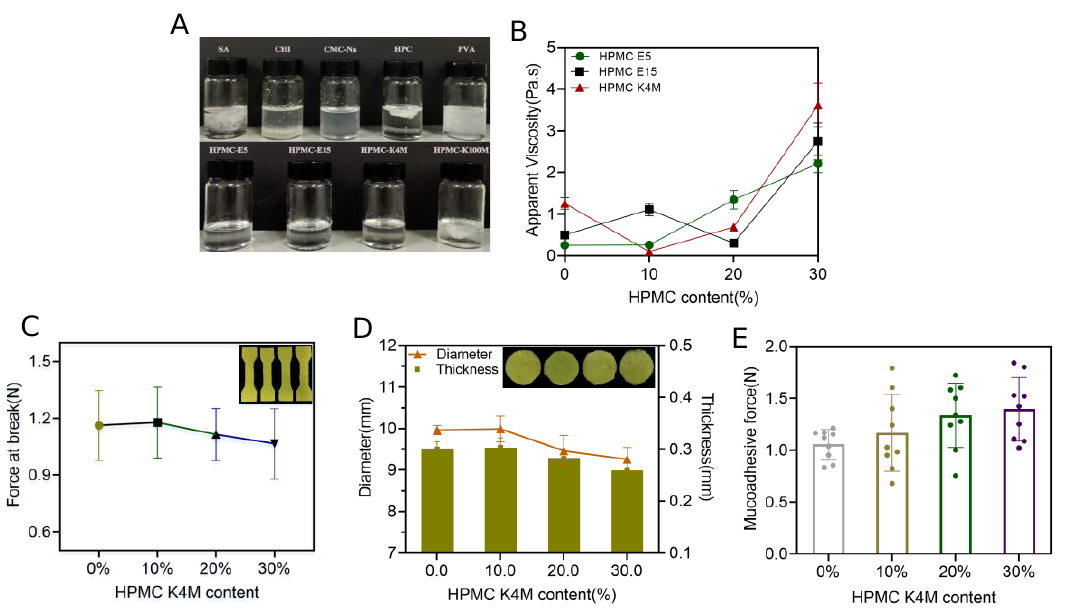
Figure 6. ( A ) The physical state of adhesive materials mixture; ( B ) viscosity of the printing resin containing HPMC E5, E15, K4M at different concentrations (n = 6); ( C ) effect of HPMC K4M on the force at break of 3D-printed oral films (n = 6); ( D ) effect of HPMC K4M on the thickness and diameter of 3D-printed oral films(n = 15); ( E ) effect of HPMC K4M on the mucoadhesive force of 3D-printed oral films (n = 6).